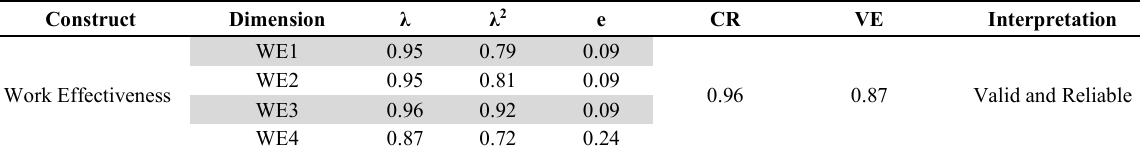
Validity and Reliability Tests on Work Effectiveness